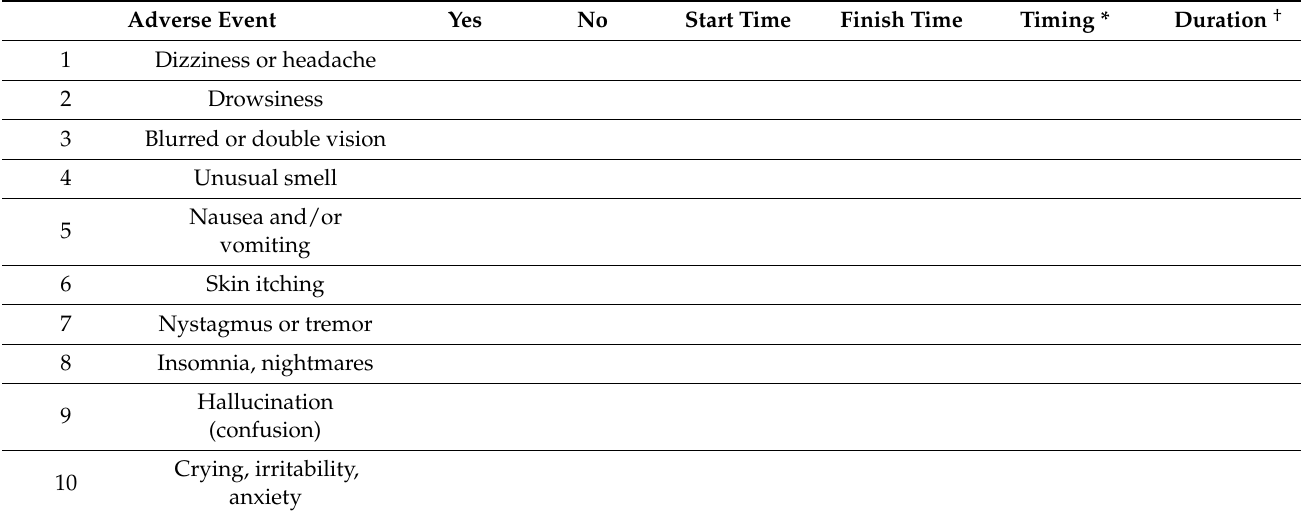
Table 1. Adverse events